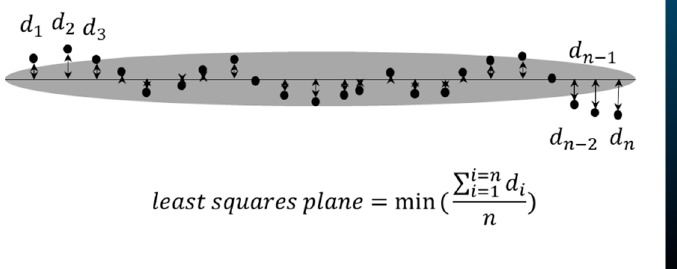
11 of 20 Figure 9. Normalized histogram for three samples.